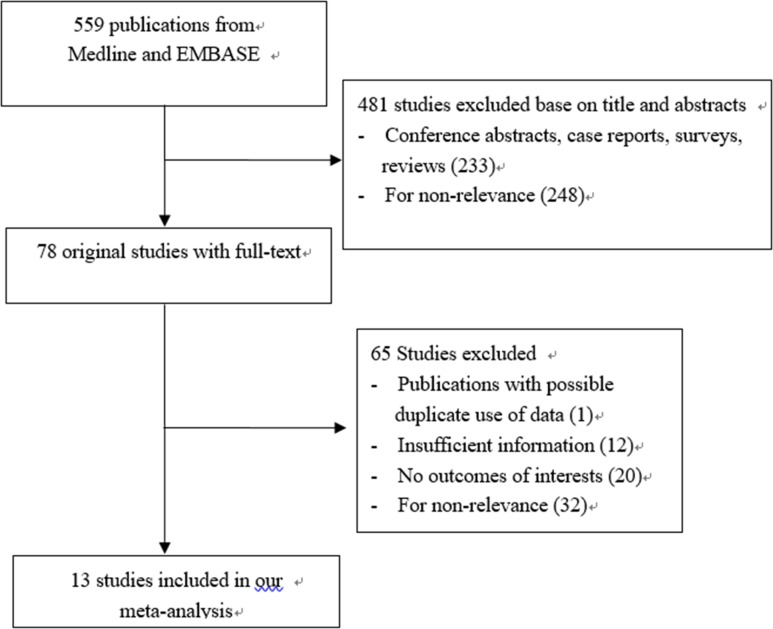
The flow chart of systematic studies search and selection procedure.